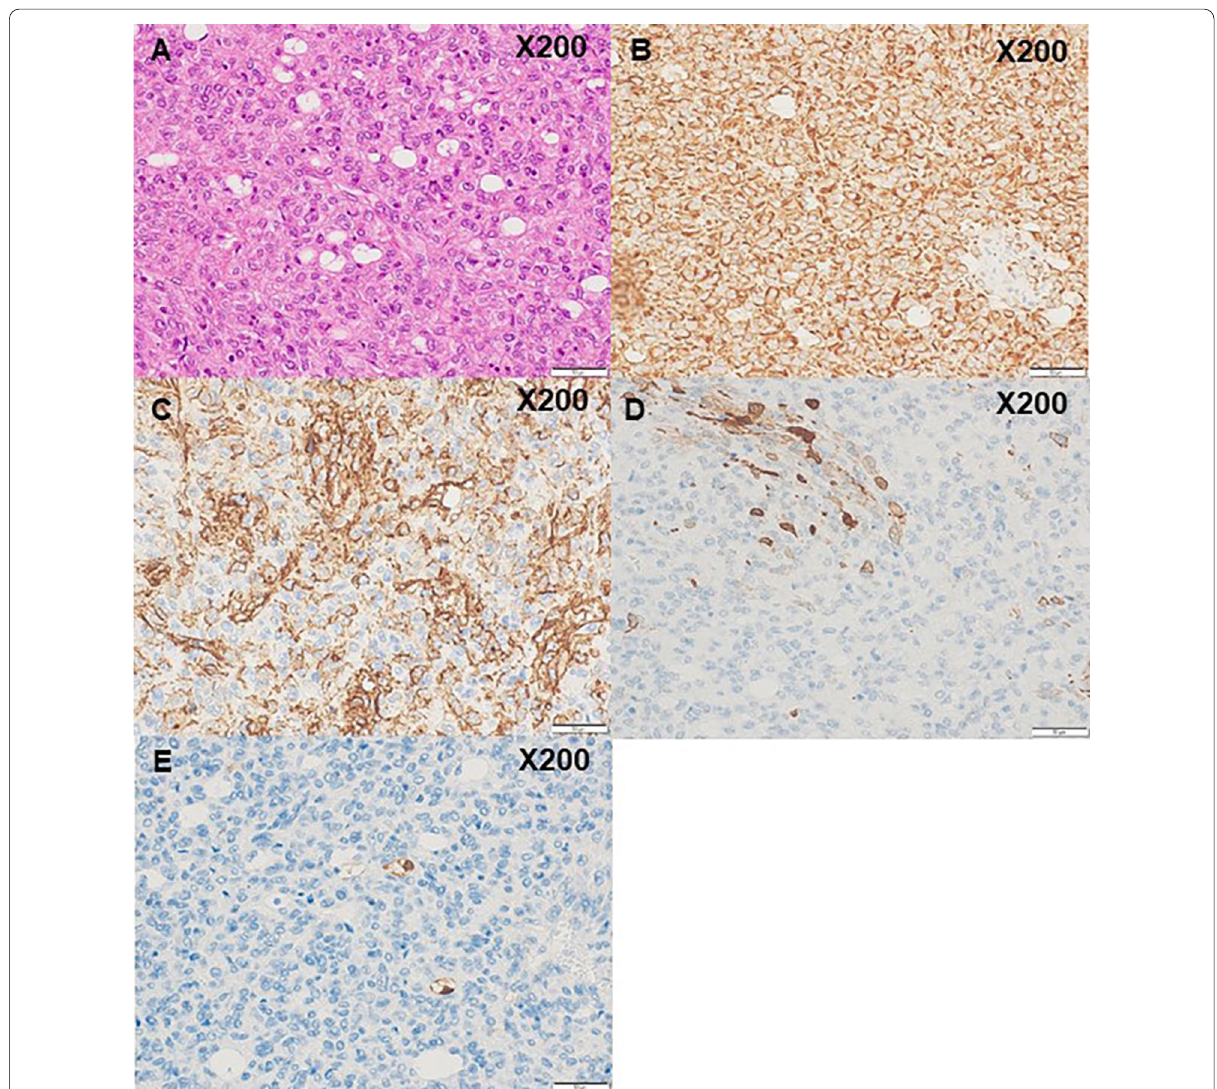
Fig. 3 Microscopic findings of the tumor. A Hematoxylin & Eosin staining ( 200). The tumor was composed of pleomorphic, spindle-shaped cells × forming fascicular structures with scattered lipoblasts intervening in varying stages. B Vimentin, C CD34 staining D alpha-SMA staining E S-100 staining. Immunohistochemically, tumor cells were diffusely positive for vimentin and focally positive for CD34 and alpha-SMA. Lipoblasts were focally positive for